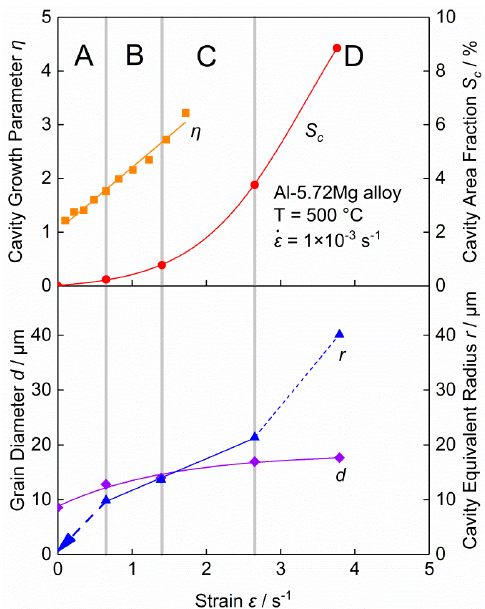
Figure 6. The cavity growth parameter, η , cavity area fraction, S c , cavity equivalent radius, r , and dynamic recrystallization grain size, d , at different superplastic tensile stages at 500 °C and 1 × 10 − 3 s − 1 .